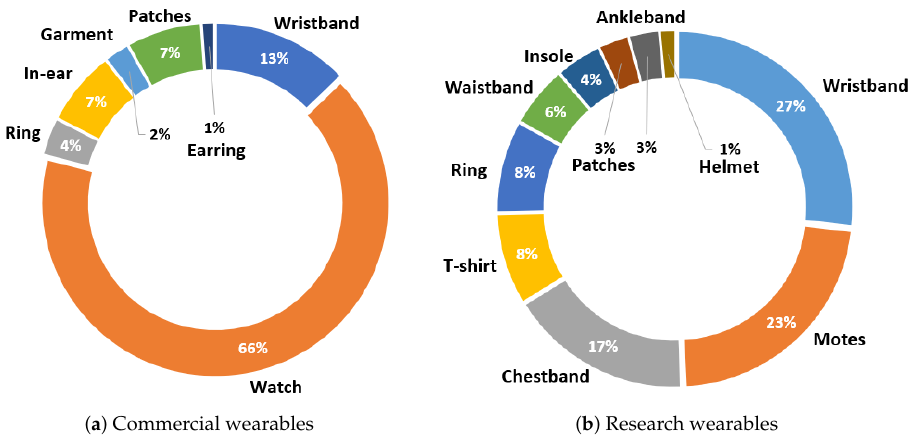
Figure 12. Distribution of the type of wearable devices marketed ( a ) and the type of wearables used in the scientific works ( b